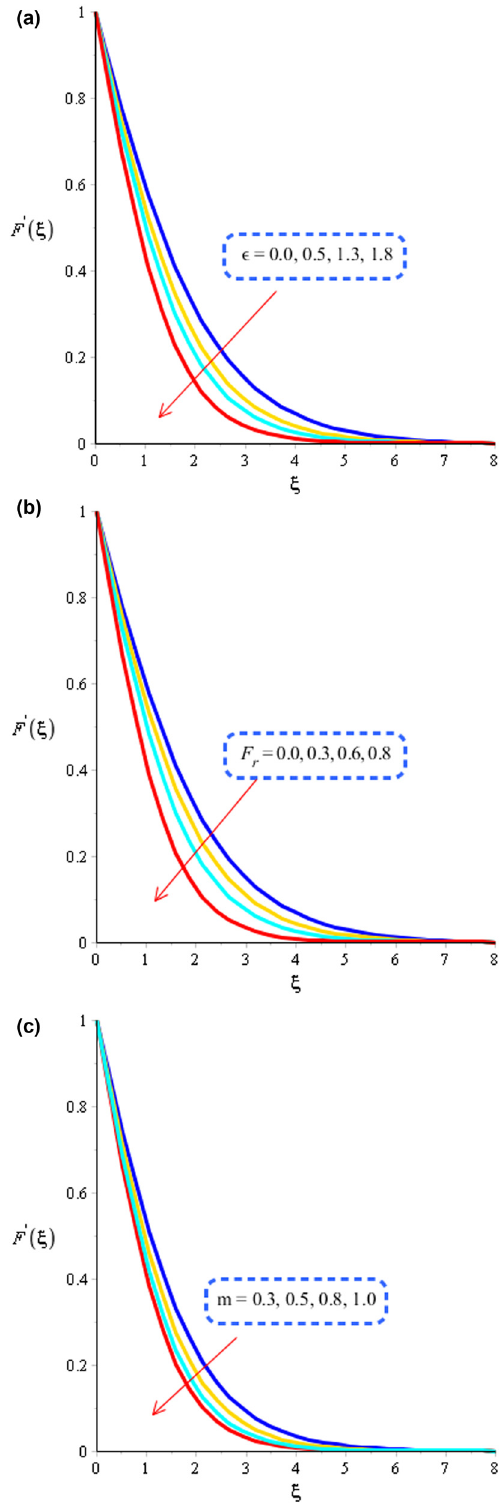
Figure 3: ( a ) Role of ε on velocity curves. ( b ) Role of F r on velocity curves. ( c ) Role of m on velocity curves.